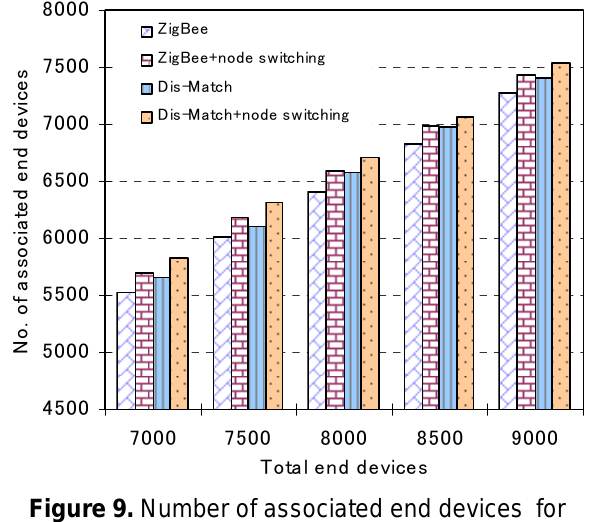
Figure 9. Number of associated end devices for dynamic network